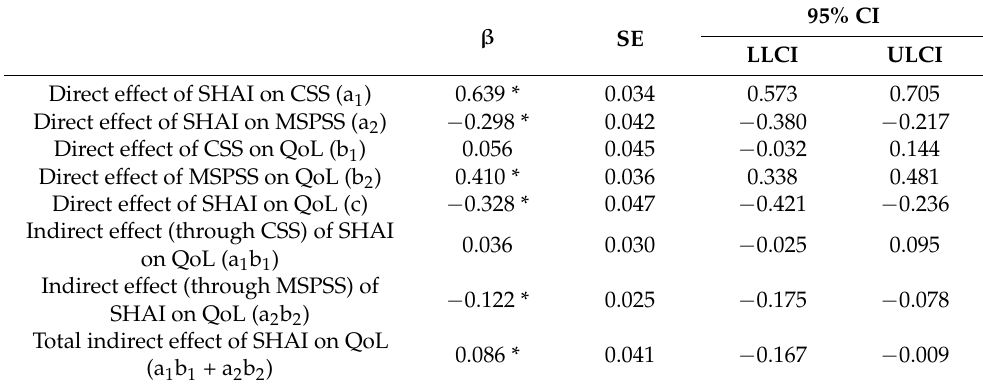
Table 4. Results of mediation